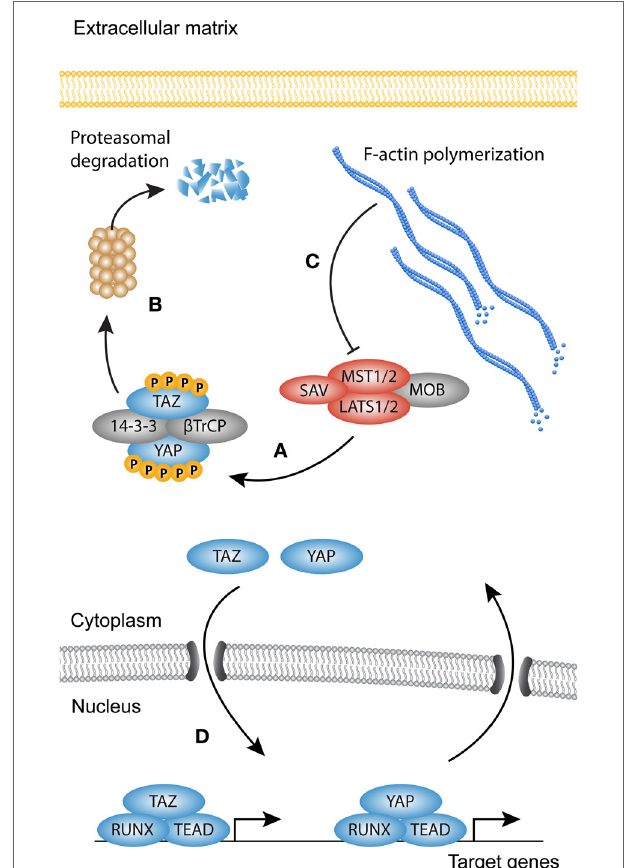
FiGURe 3 | YAP and TAZ signaling . Simplified scheme showing activation of YAP and TAZ. (A) When the Hippo kinase complex [comprised of Serine/ threonine-protein kinases (MST1/2), MOB kinase activator 1 (MOB1), Salvador (SAV), and serine/threonine-protein kinases (LATS1/2)] is active, YAP and TAZ become phosphorylated on multiple sites, creating a so-called phosphodegron. (B) Both YAP and TAZ are then sequestered in the cytoplasm by 14-3-3 proteins or targeted for degradation by β -TrCP. (C) Polymerization of the F-actin cytoskeleton inhibits the activity of MST1/2, rendering the core kinase complex inactive (several other upstream activators of the core kinase complex are not shown). (D) YAP and TAZ now translocate to the nucleus where they associate with transcription factors such as Runt-related transcription factor (RUNX) and TEA domain family member (TEAD) to modulate